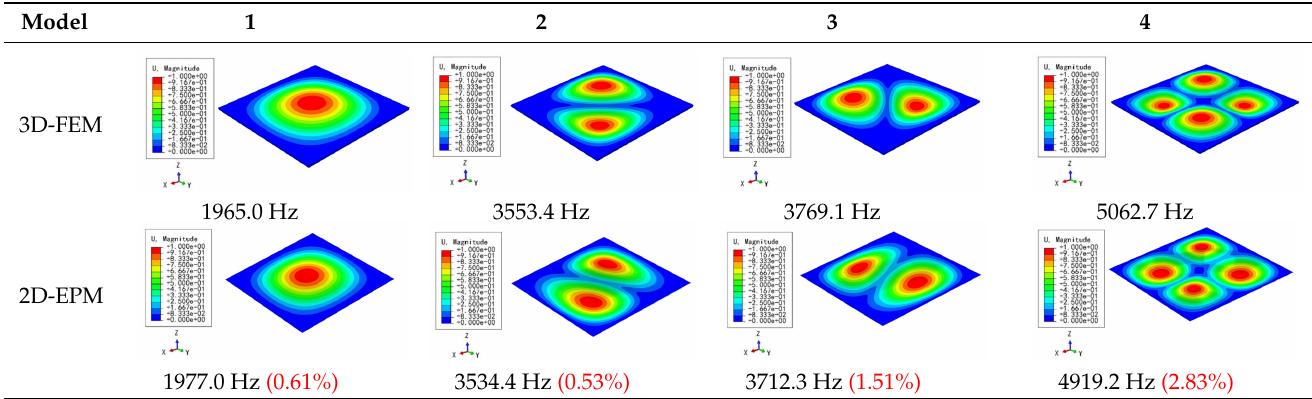
Table 13. Comparison of the first four free vibrations of the diamond HSP under CCCC boundary conditions predicted by different models.